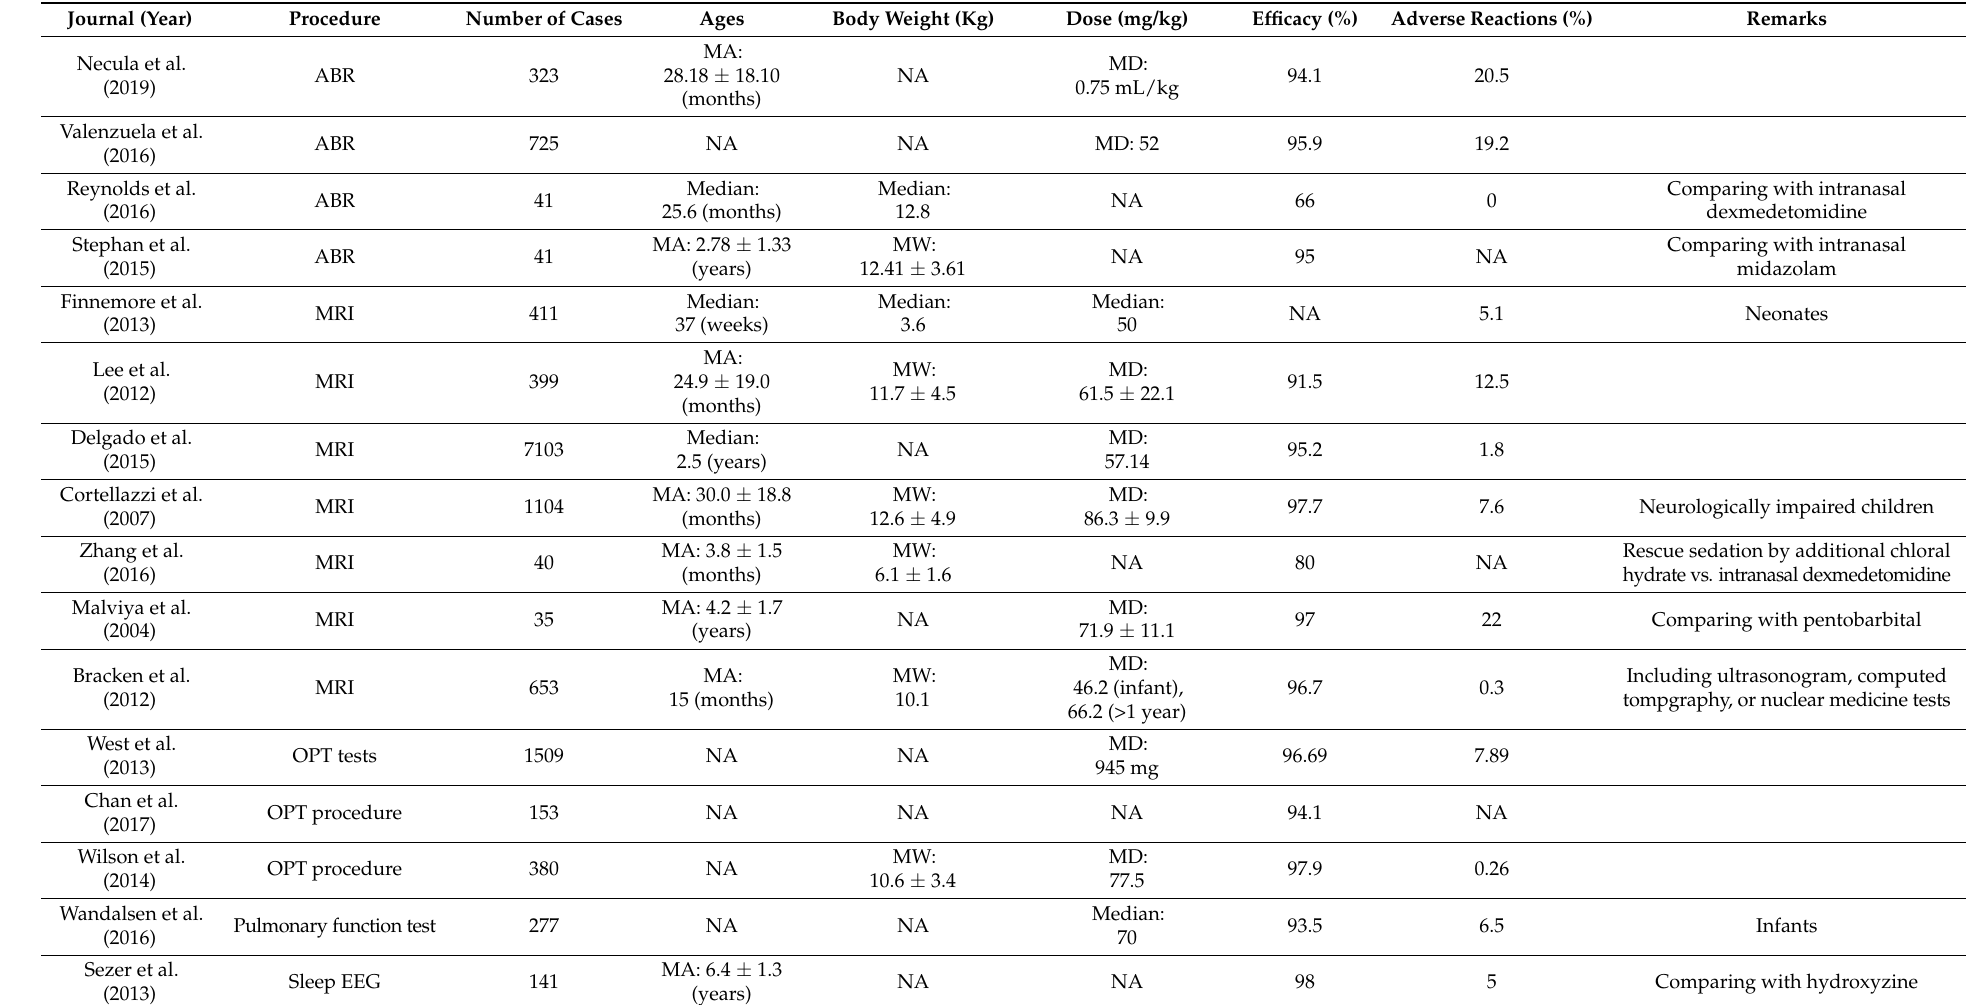
Table 3. Efficacy and adverse reactions of chloral hydrate in pediatric patients during recent